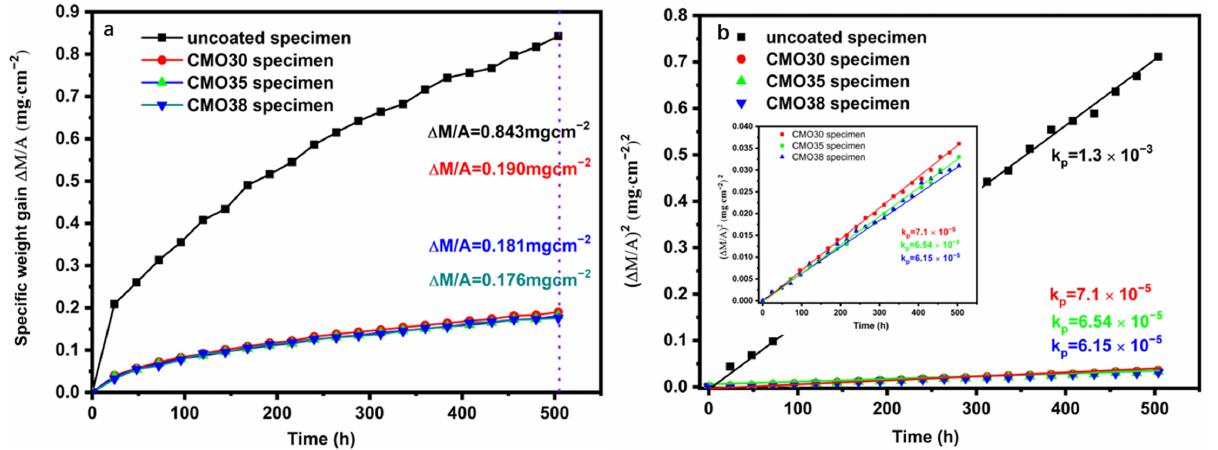
Figure 5. ( a ) weight gain and ( b ) oxidation kinetics for uncoated and coated specimens (CoMnO30, CoMnO35, CoMnO38).